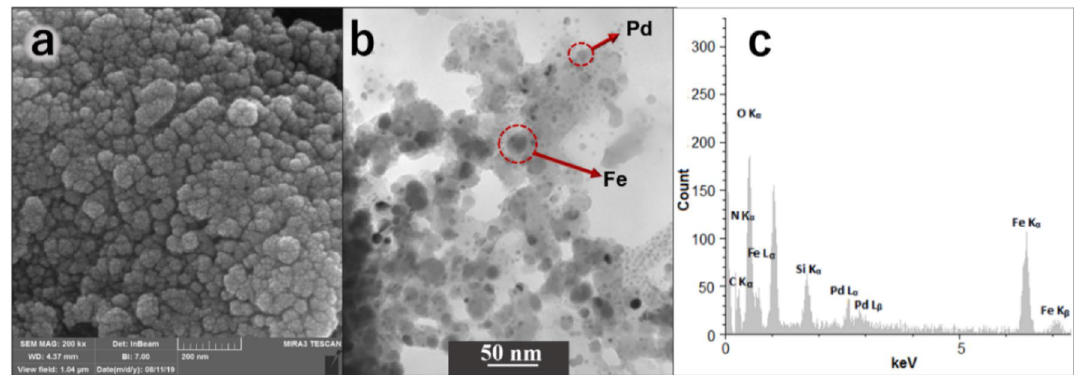
Figure 3. SEM ( a ), and FE-TEM ( b ), analyses and EDS spectrum ( c ) of MNPs@SiO 2 -NH 2 @Pd(dpa)Cl 2